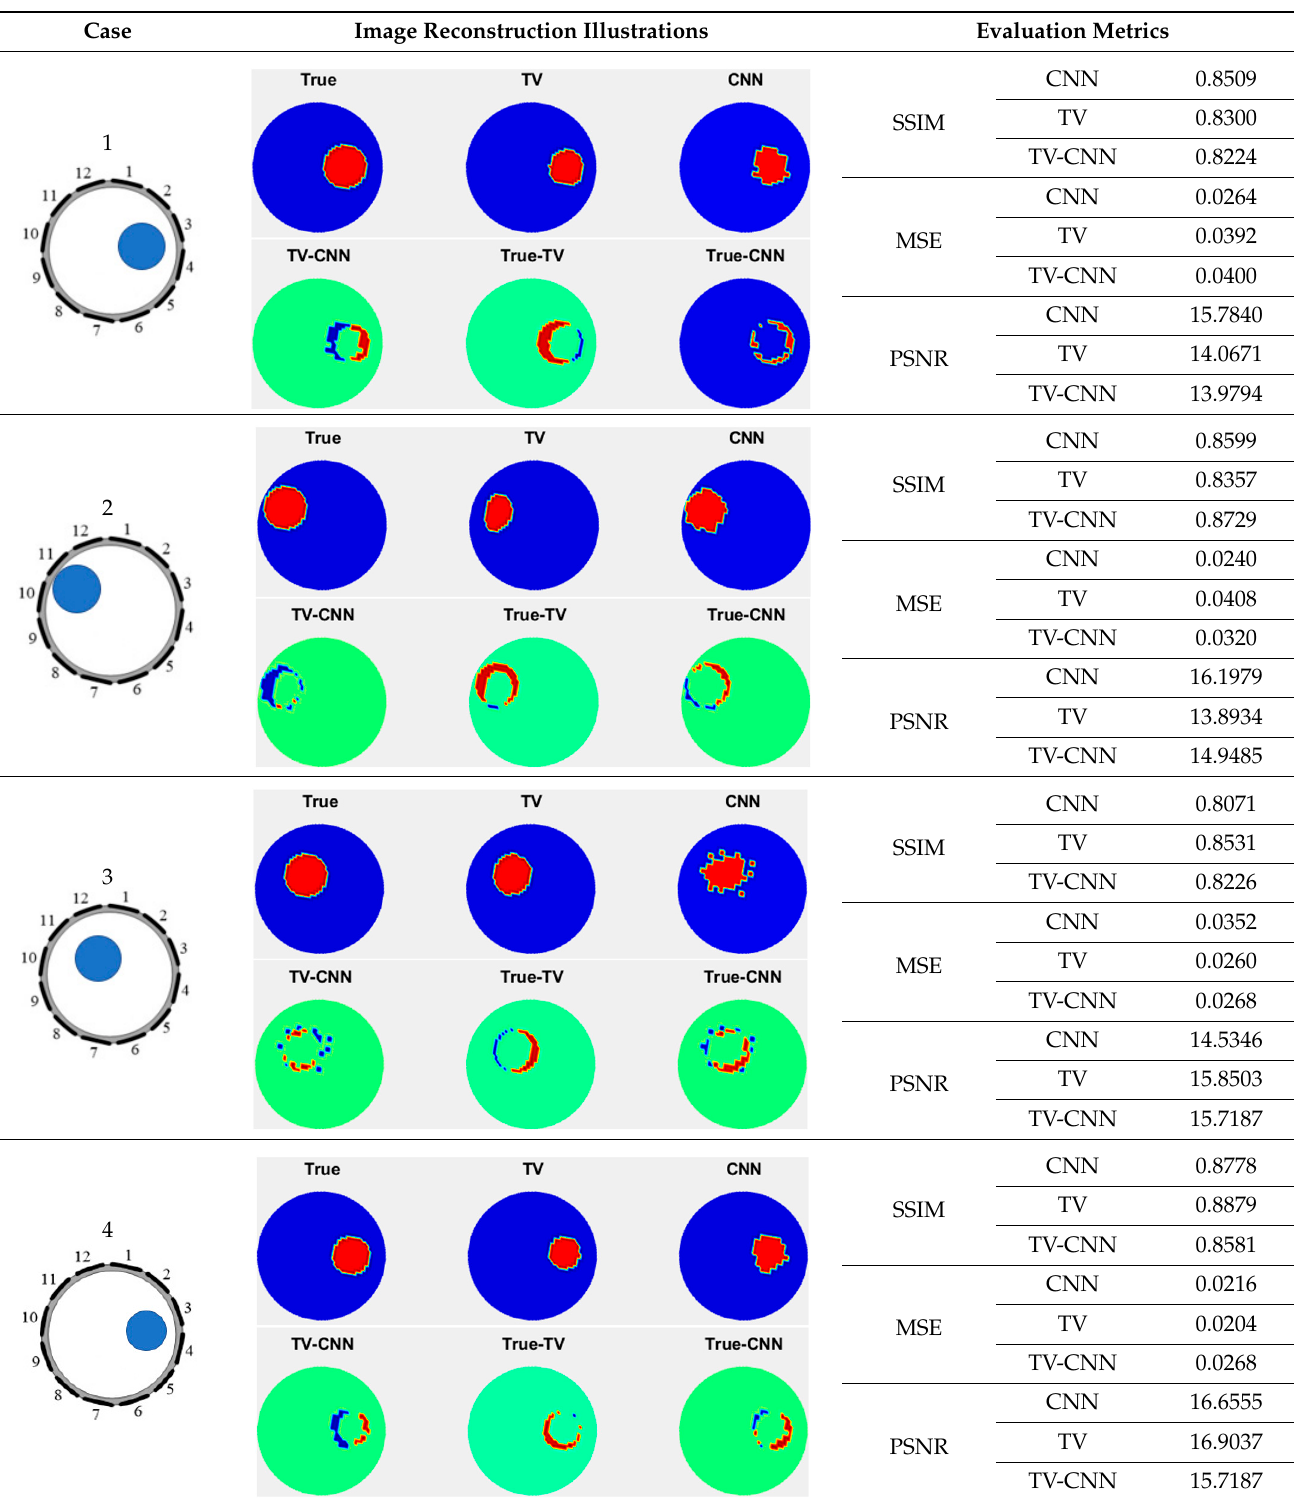
Figure 9. ( a ) A photo of the 12-electrode CCERT (capacitively coupled electrical resistance tomography) system and ( b ) the 12-electrode CCERT system setup. Table 5. Experimental reconstruction results and accuracy analyses.